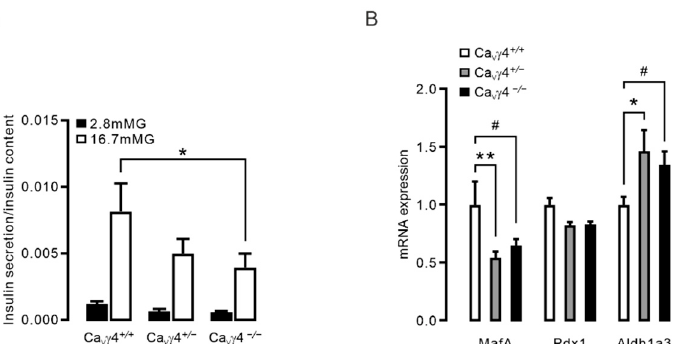
Figure 2. Insulin secretion and gene expression in Cacng4 knockout mouse islets: ( A ) Glucose-stimulated insulin secretion in Ca V γ 4 +/+ , Ca V γ 4 +/ − and Ca V γ 4 − / − mouse islets. n = 6, 7 and 6 mice, respectively. * p = 0.016. ( B ) MafA , Pdx1 and Aldh1a3 mRNA expression in Ca V γ 4 +/+ , Ca V γ 4 +/ − and Ca V γ 4 − / − mouse islets. n = 4, 4 and 4 mice, respectively. ** p < 0.01, * p < 0.05 and # p < 0.05. Data are presented as Mean ± SEM and were analyzed with two-way ANOVA with Dunnett’s multiple comparisons test.